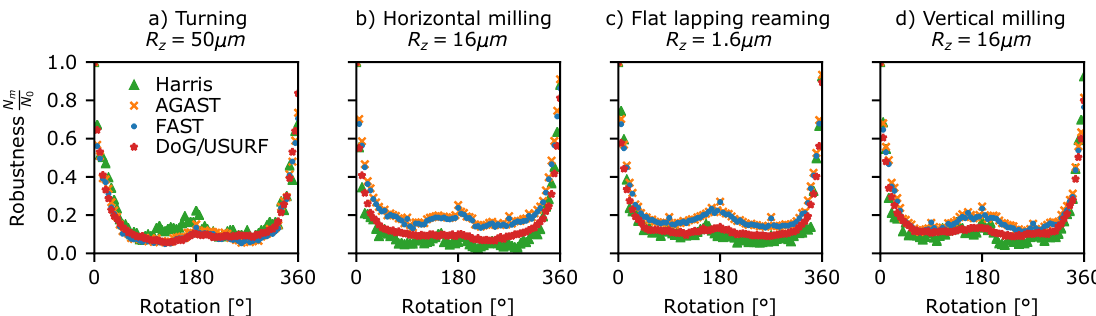
Figure 8. Detector rotational robustness plotted against rotation angle for a selection of surface treatments shown in Figure 1. ( a ) Turning R z = 50 µ m, ( b ) horizontal milling R z = 16 µ m, ( c ) flat lapping reaming R z = 1.6 µ m, and ( d ) vertical milling R z = 16 µ